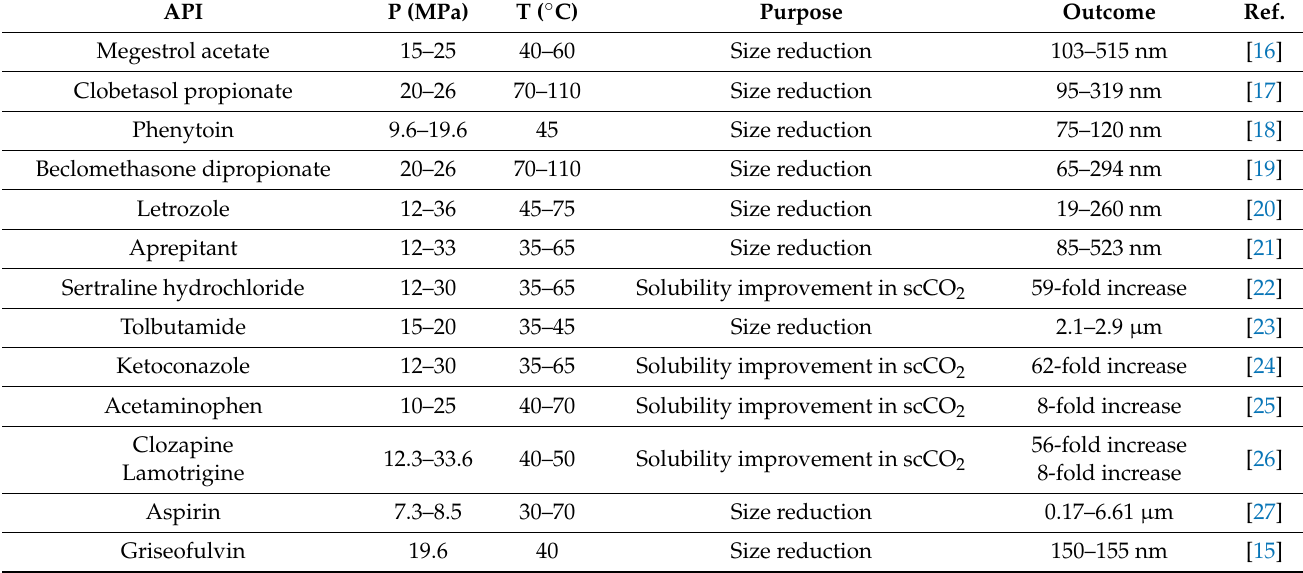
Table 2. Examples of the application of menthol as a solid co-solvent with scCO 2